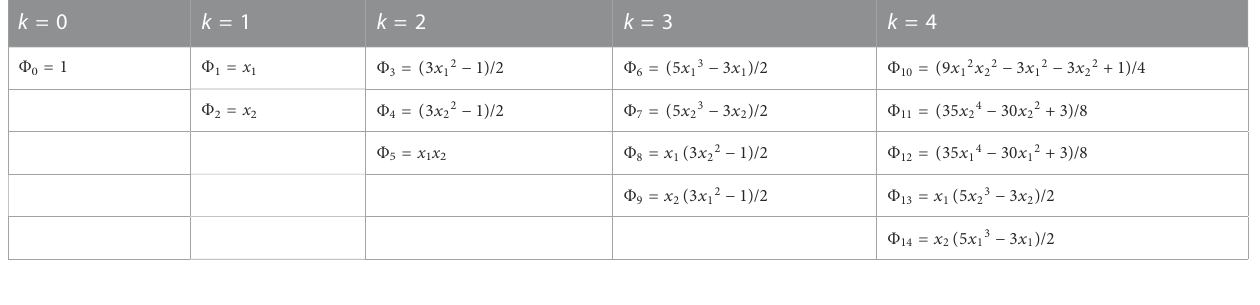
TABLE 3 Four Legendre polynomials Φ j with two variables ( k goes from 0 to 4).